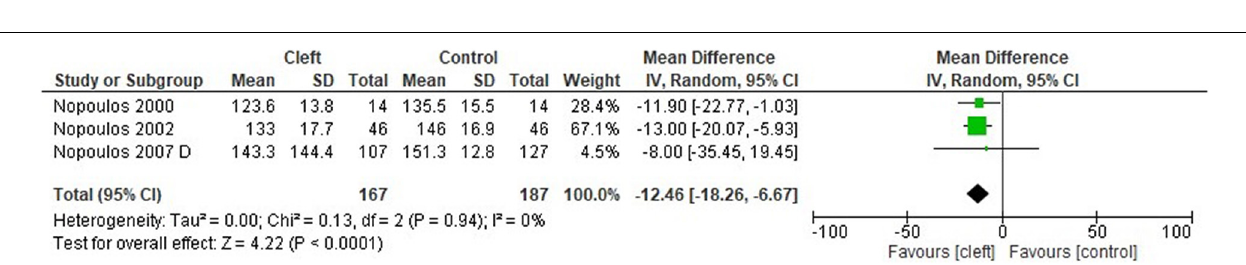
FIGURE 4 | Forest plot for total volume of the cerebrum (cm 3 ) with subgroup analysis (non-syndromic vs. mixed).